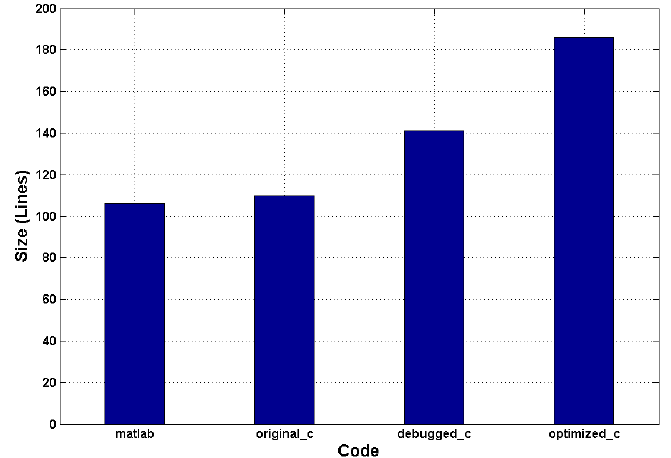
Figure 12. Size estimation of the source code: matlab and original_c are the MATLAB and C version of the target algorithm, while debugged_c and optimized_c are the versions debugged and optimized for